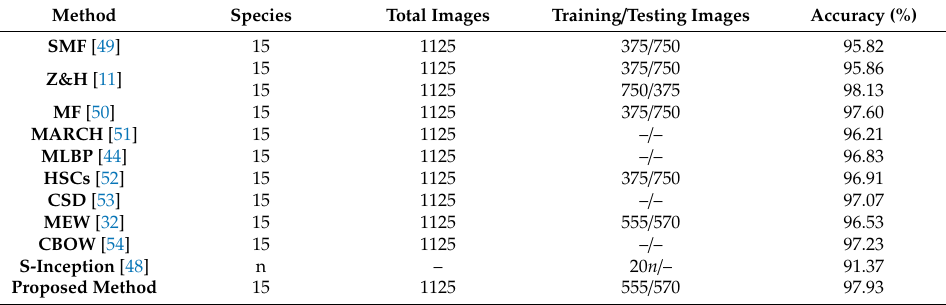
Table 4. Comparison of proposed method with existing methods on Swedish